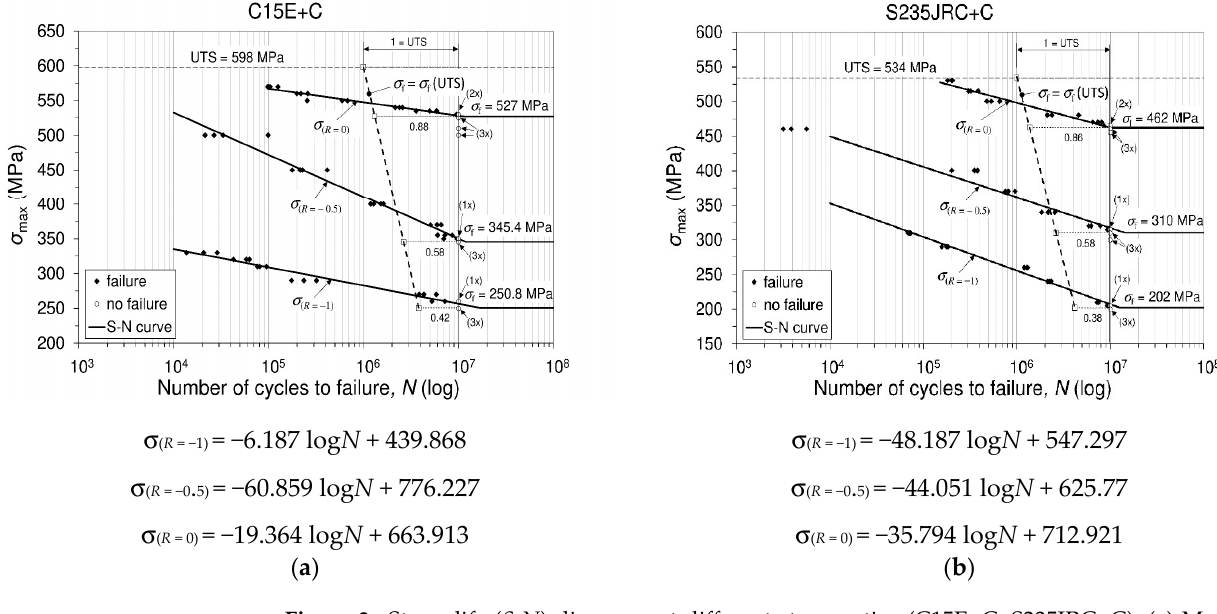
Figure 3. Stress-life ( S-N ) diagrams at different stress ratios (C15E+C; S235JRC+C). ( a ) Material C15E+C (1.1141) and ( b ) Material S235JRC+C